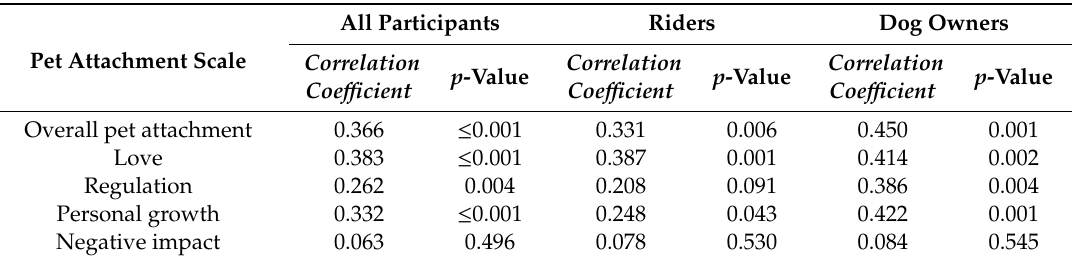
Table 6. Spearman correlation of mood estimation and pet attachment